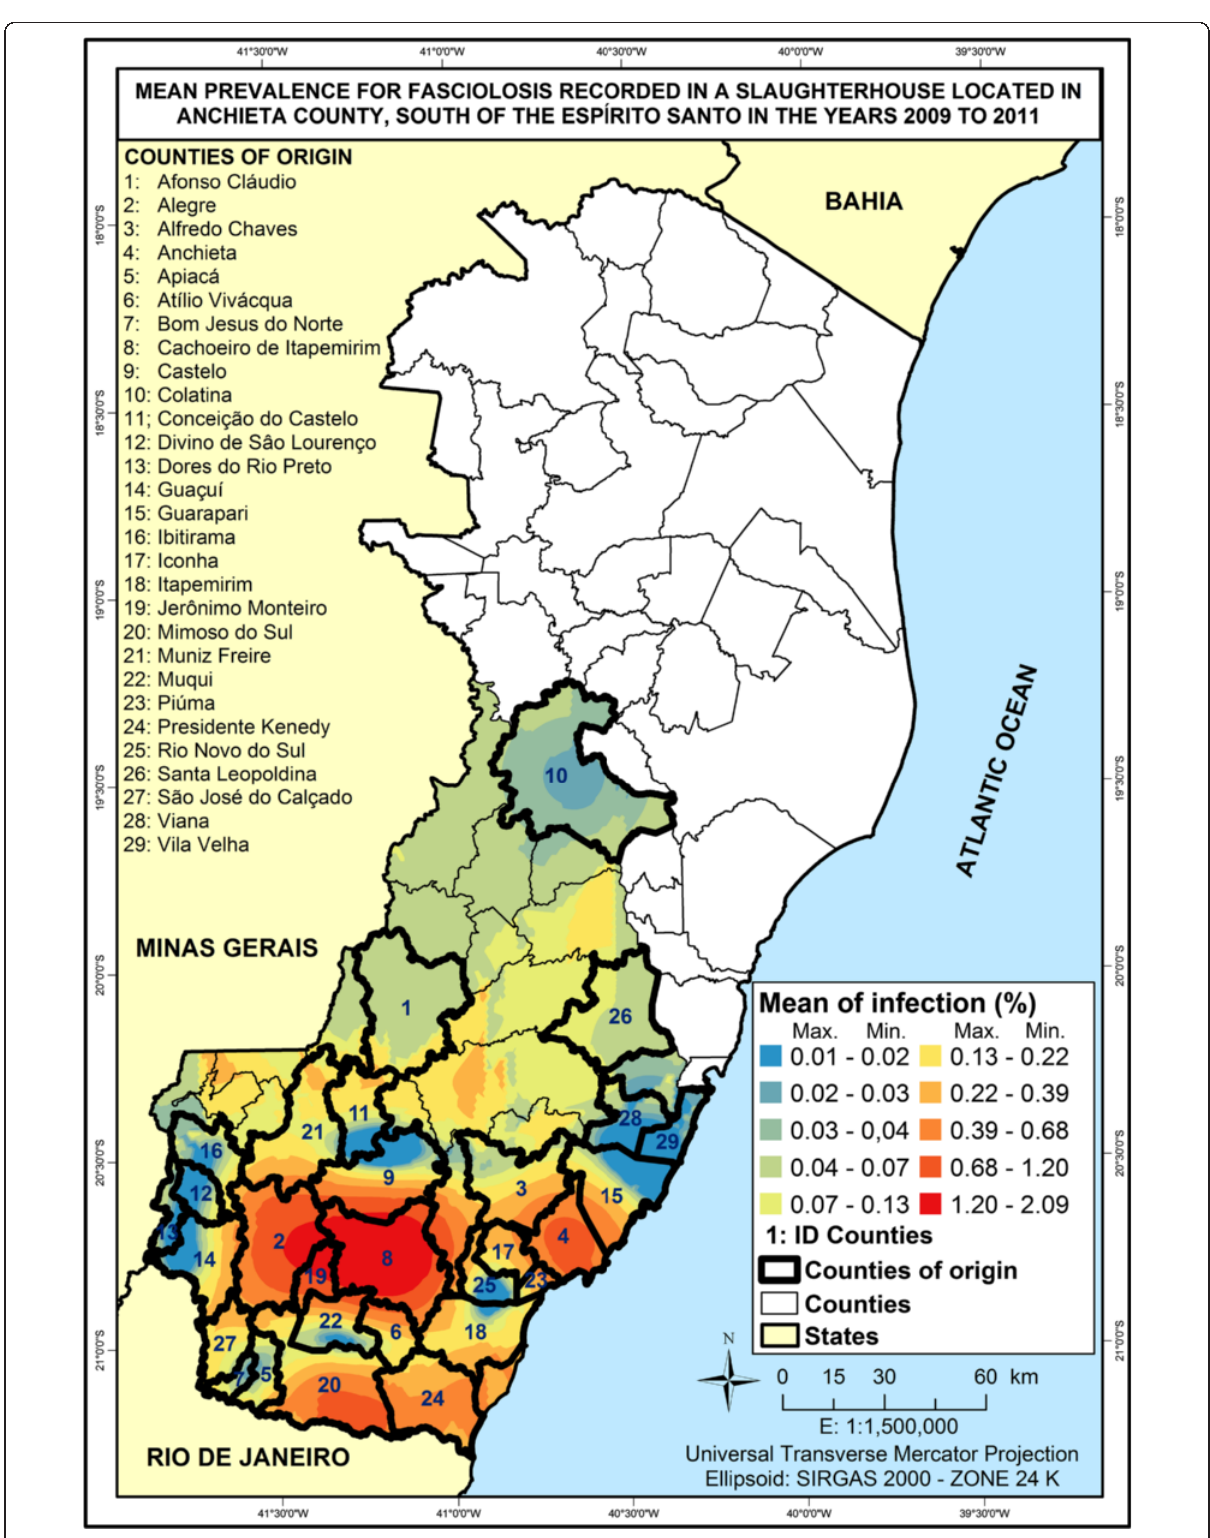
Figure 4 Map showing the prevalence of bovine fasciolosis and its origins in Espírito Santo from 2009 to 2011 according to data provided by a slaughterhouse located in